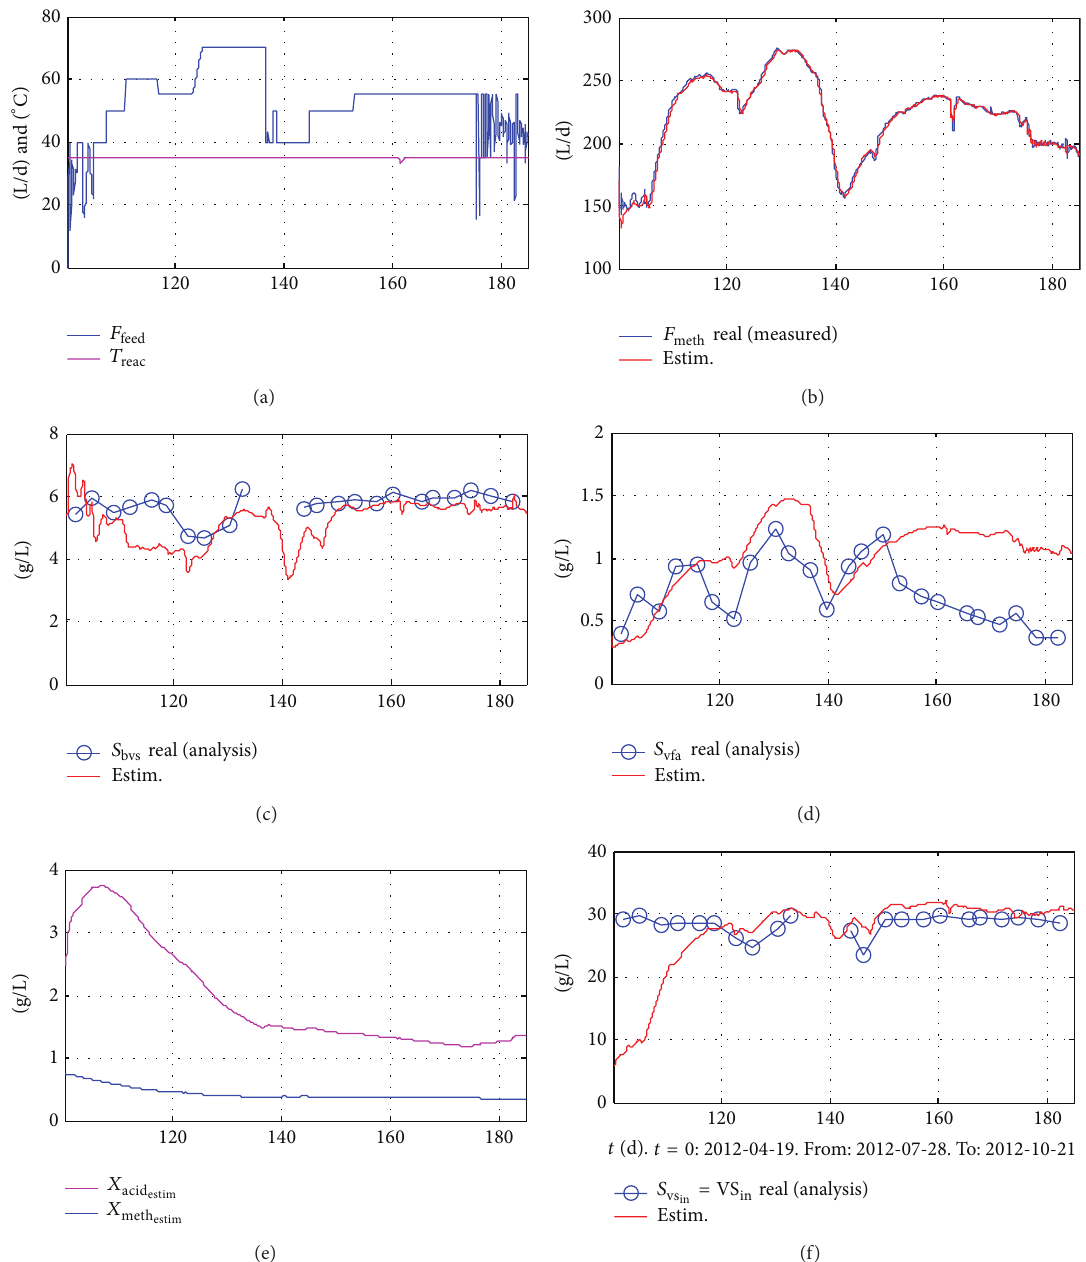
Figure 4: Estimates and real data from laboratory analysis with UKF. Standard deviations of estimation errors: 𝑆 𝑆 : 1.02g/L. (For 𝑆 vs in